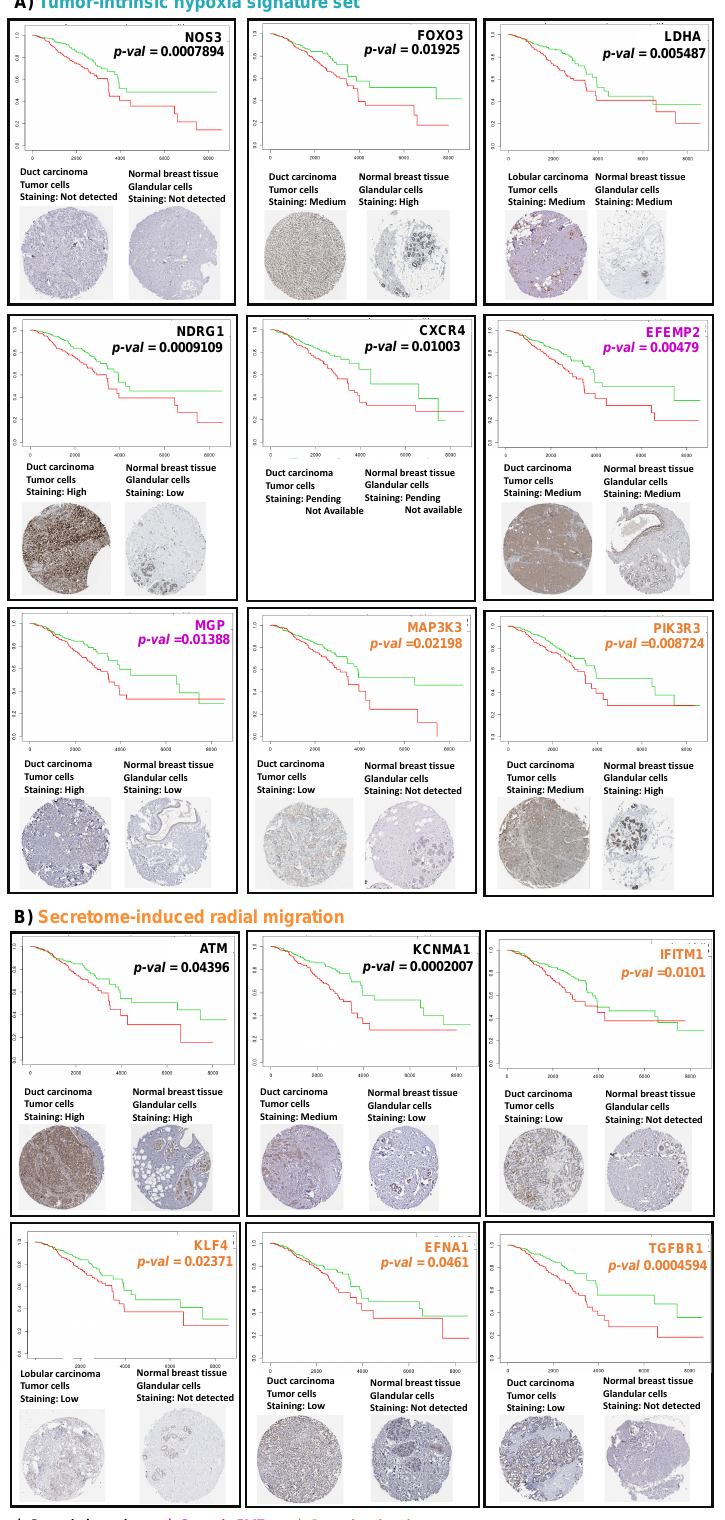
Figure 7. Modulators of collective migration in large and small migratory tumors are associated with low survival rate and prognosis